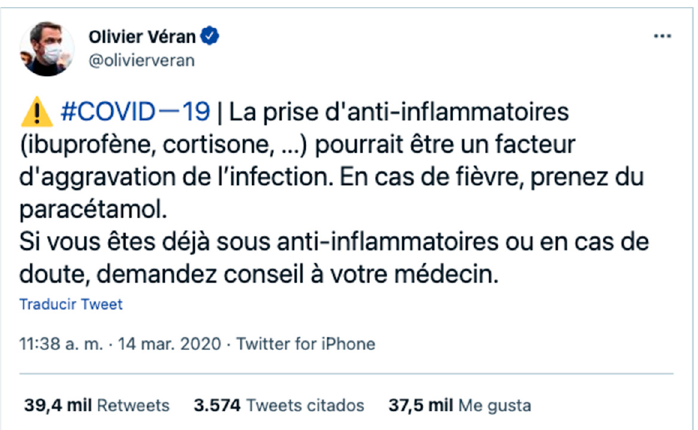
Figure 1. Tweet from the French Health Minister. Source: Twitter @olivierveran.